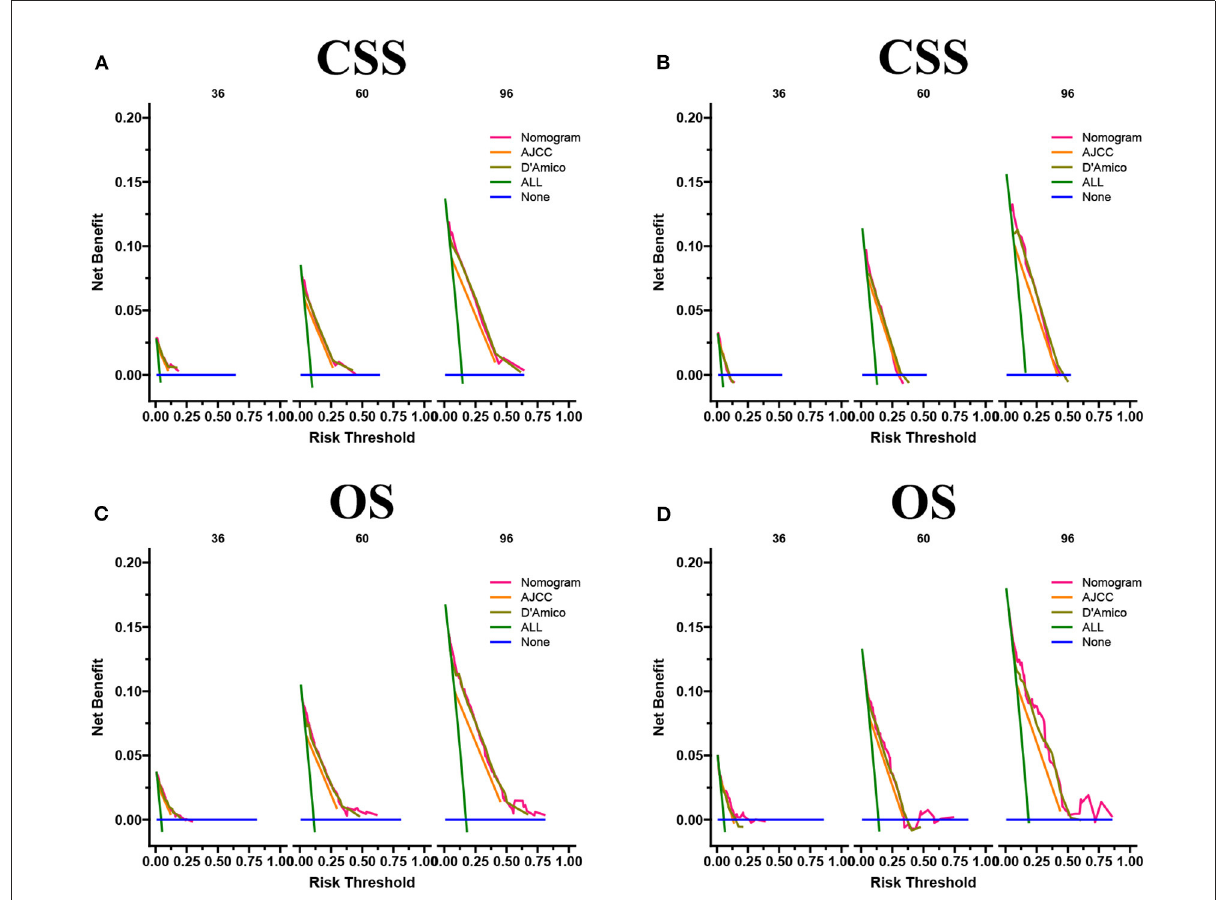
FIGURE5 DCA of the nomograms for predicting CSS (A,B) and OS (C,D) of the training set and validation set.